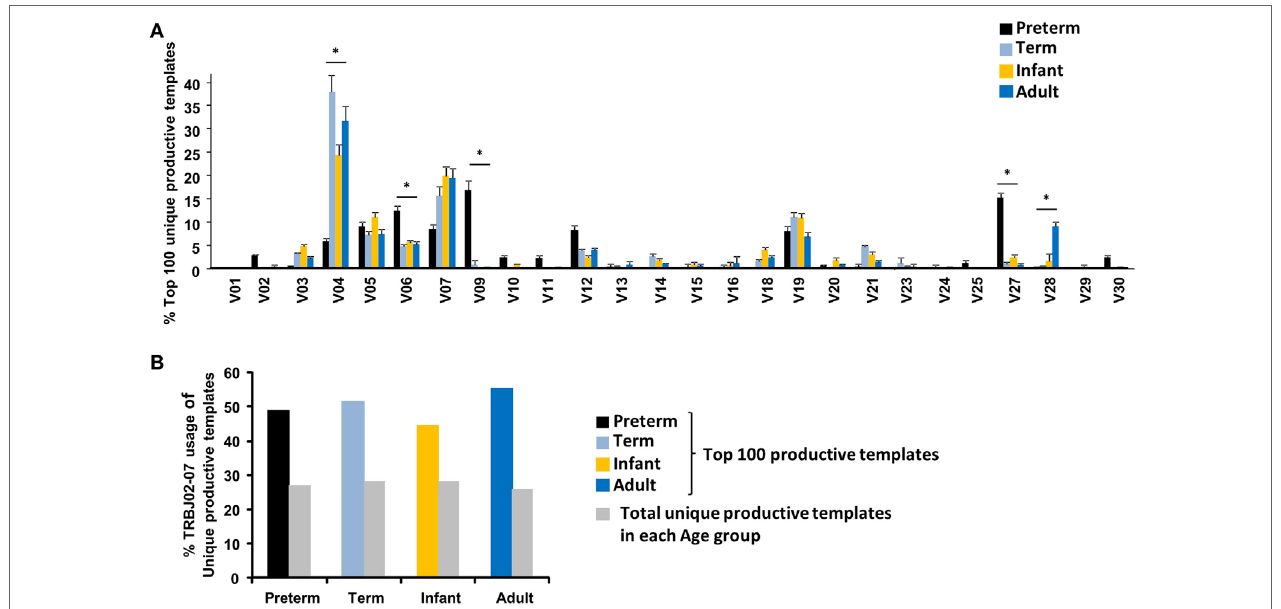
FigUre 2 | Differential TCR V β family usage in the extremely preterm neonate’s most frequent clones. (a) The frequency of V β gene family usage (mean ± SEM) for the top 100 unique productive templates within each age group is shown. Unpaired Student’s t -test was performed to compare an age group to one other age group. * represents < 0.05. (B) The frequency of TRBJ02–07 usage in the total unique versus the top 100 repertoire